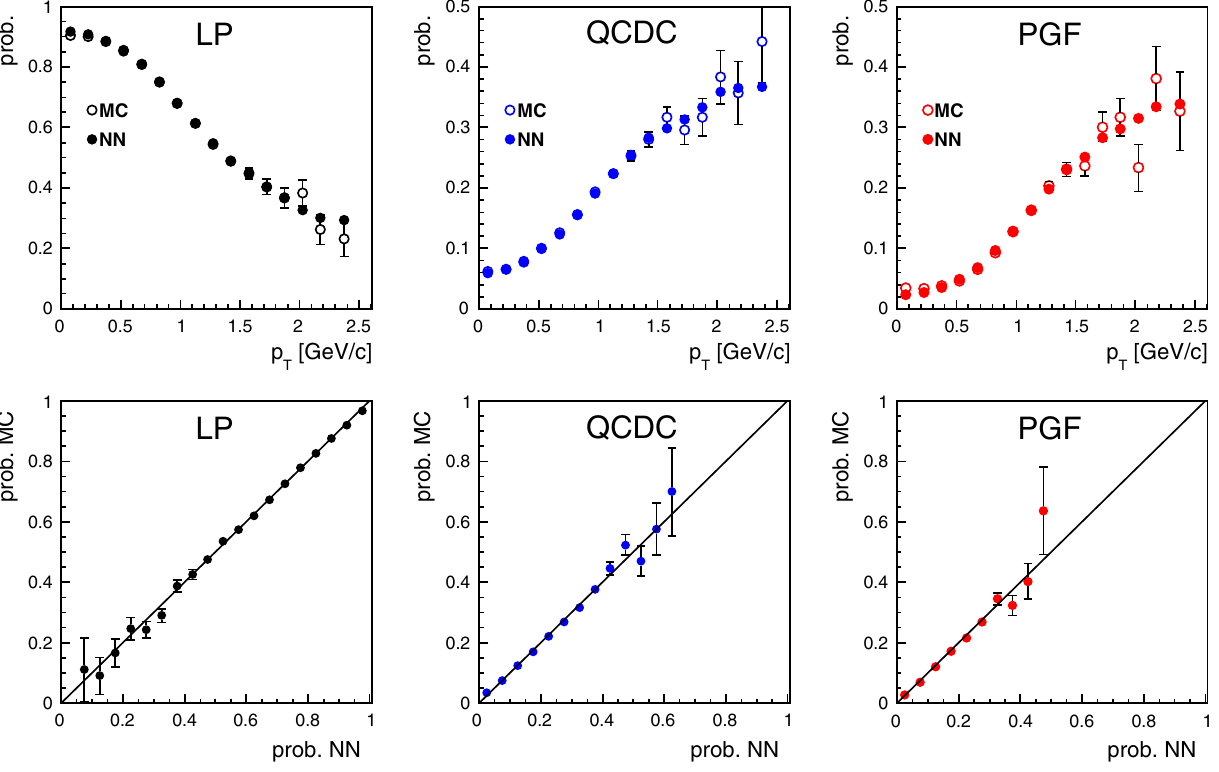
Fig. 3 Top panels Values of R LP , R QCDC , R PGF obtained from MC and NN as a function of p T . Bottom panels MC probabilities in bins of NN probabilities